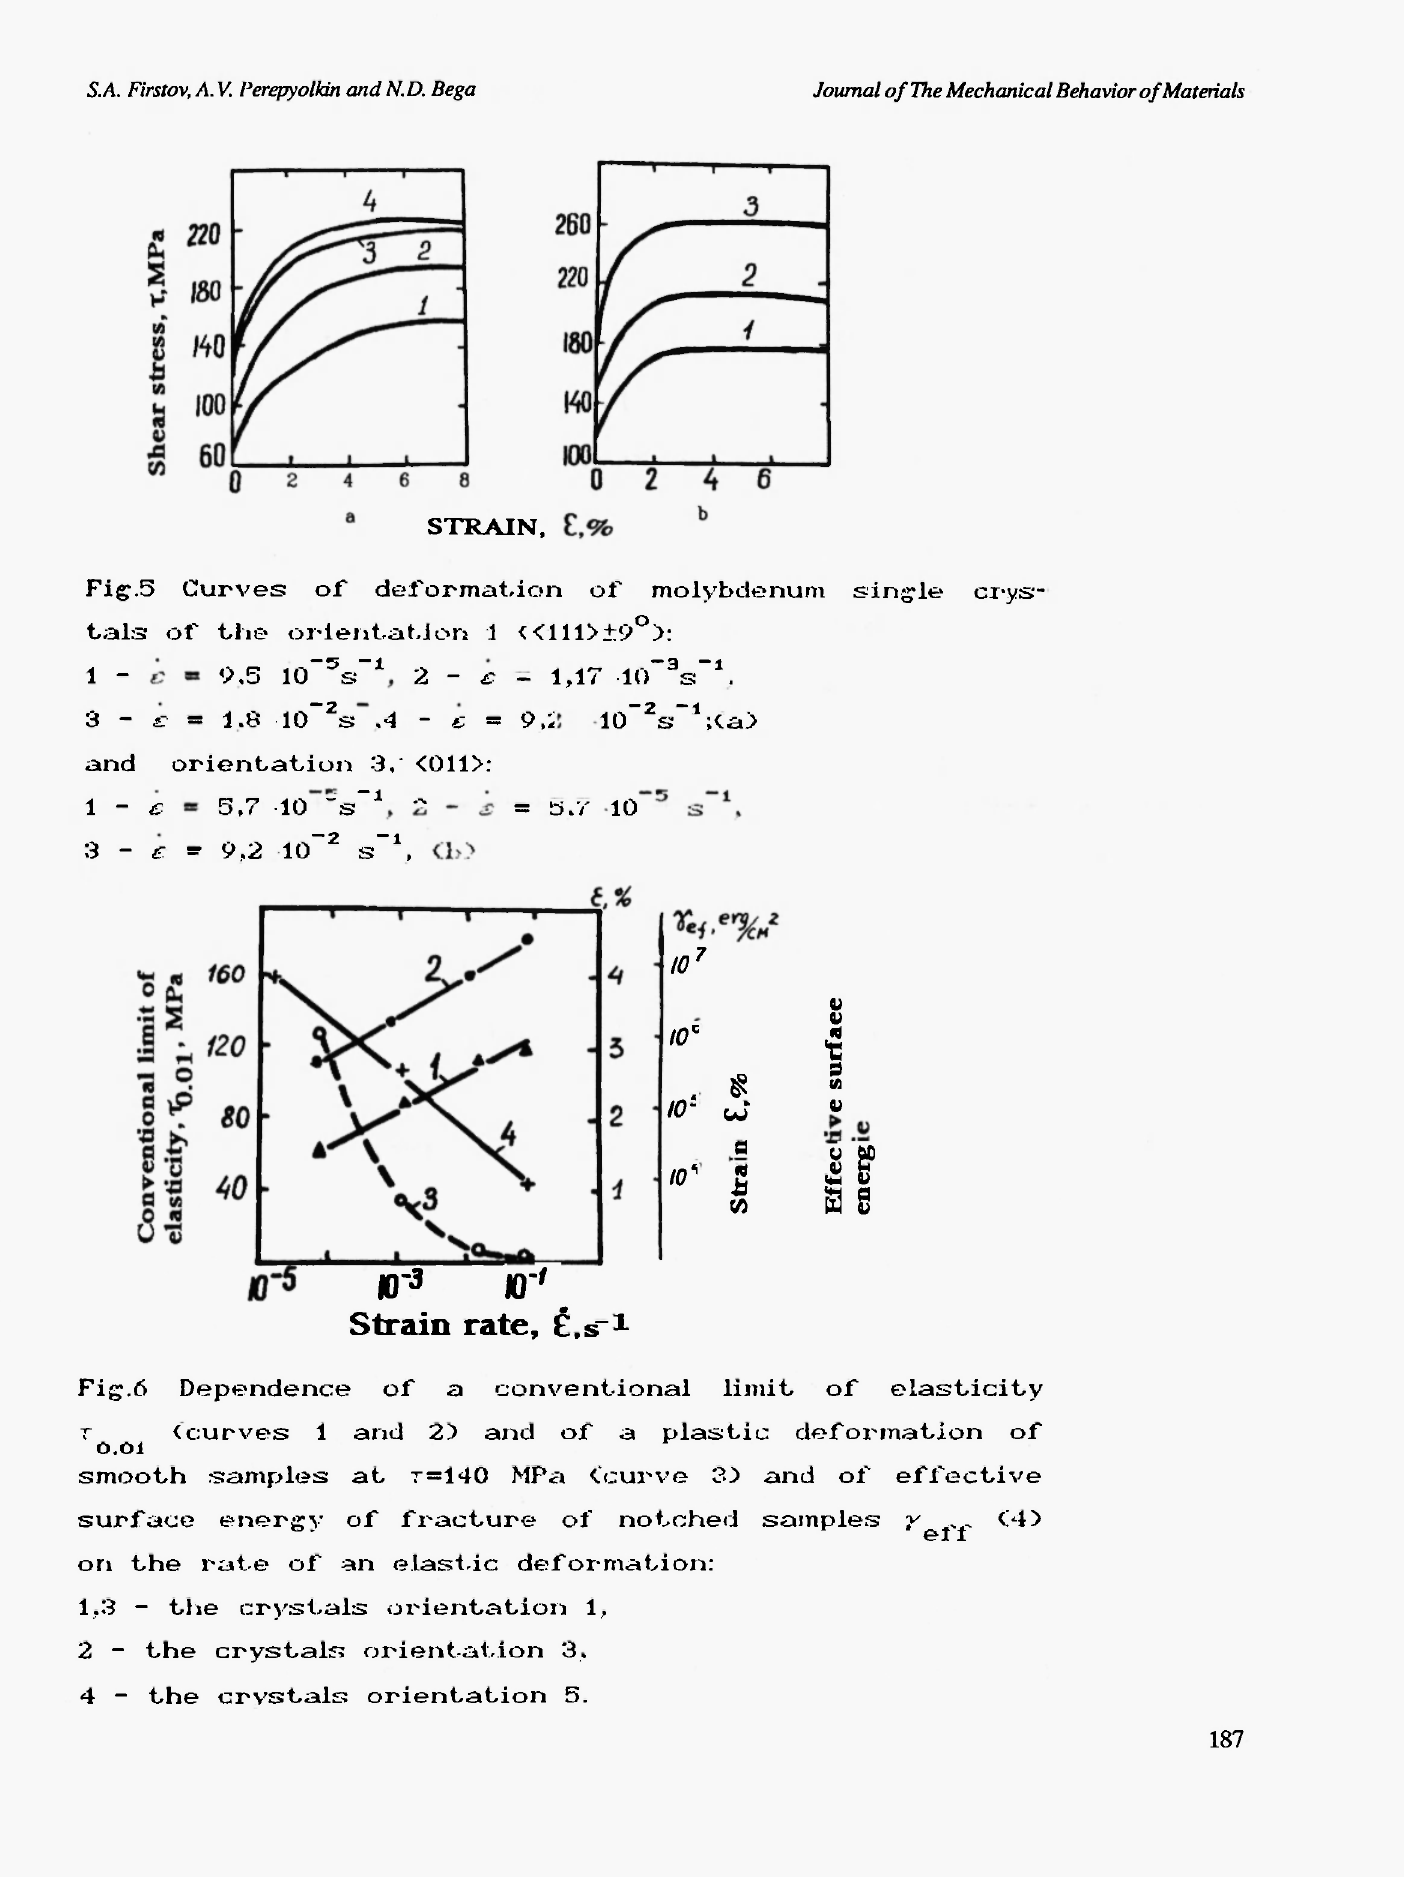
Fig.6 Dependence of a conventional limit of e l a s t i c i ty 2) and of a plastic deformation of O.Ol smooth samples at 3> and of notched of an elastic deformation: